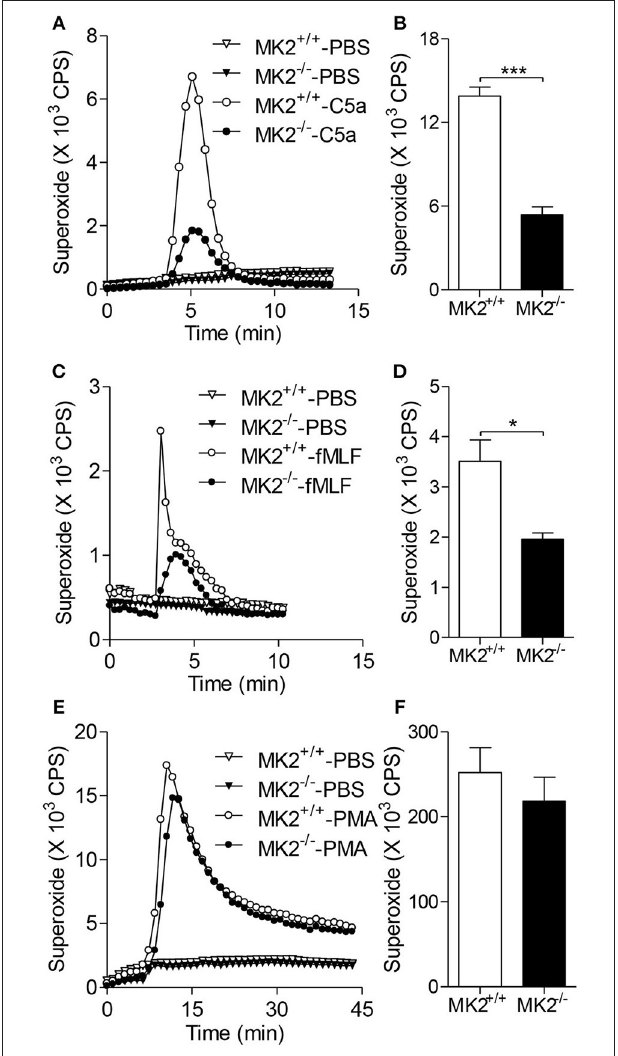
FIGURE 3 | MK2 modulated neutrophil superoxide production. Neutrophils were isolated from mice and isoluminol-ECL was used to measure superoxide production. Representative tracing showing the production of superoxide (left) and cumulative superoxide production was quantified based the area under tracing line (right). The MK2 + / + and MK2 − / − neutrophils were stimulated